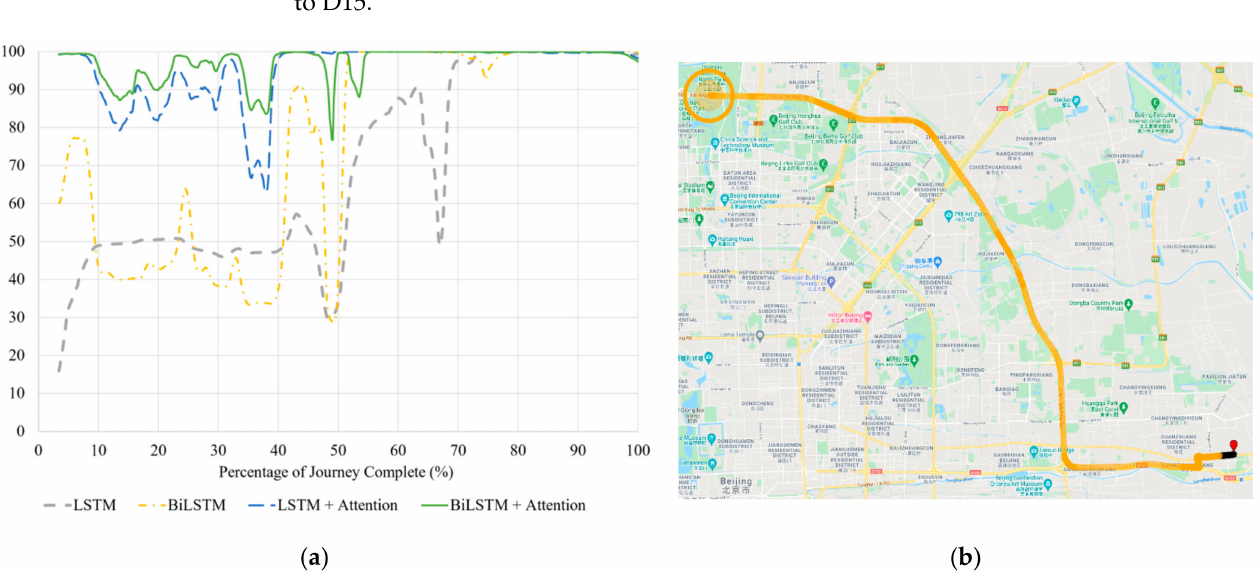
Figure 7. ( a ) Correct destination prediction certainty versus percentage complete for the seen journey to Destination 15. ( b ) BiLSTM with Attention destination predictions visualized along the same route. The red pin is the starting point. Map data ©